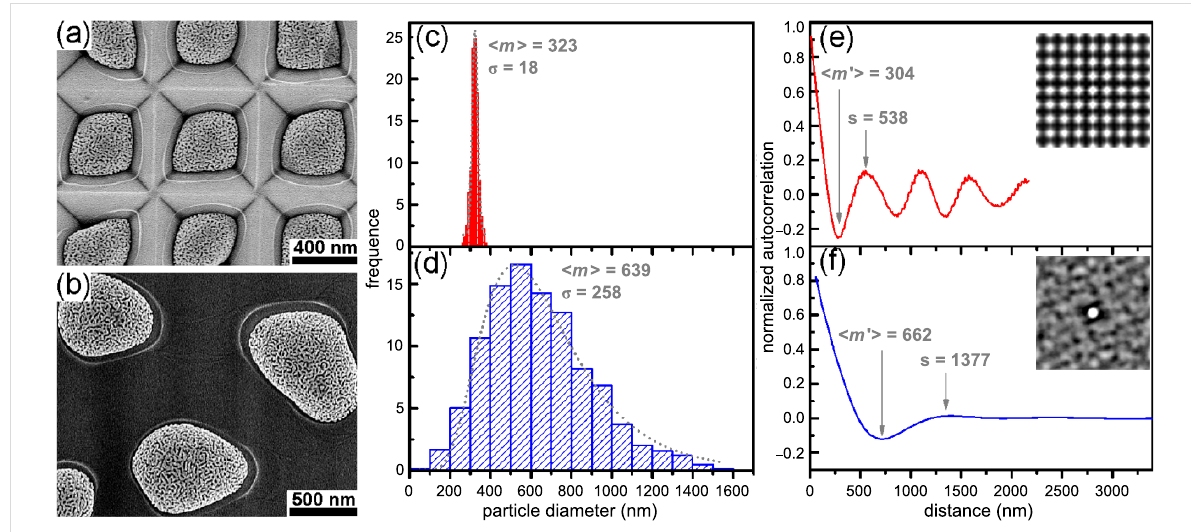
Figure 5: Data for the ordered array of nanoporous gold nanoparticles formed from the 15 nm Au/30 nm Ag multilayers on the prepatterned substrate (a, c, and e) and the irregularly distributed nanoporous gold nanoparticles formed from the 15 nm Au/20 nm Ag bilayers on the flat substrate (b, d, and f). (a, b) SEM images, (c, d) histograms of the particle diameter distributions, and (e, f) plots of radially averaged autocorrelation. Fitting curves (log- normal function) are superimposed on the histograms. The values <m> or <m ′ > and σ indicate the mean particle diameter and its standard deviation, and “s” denotes the characteristic particle spacing (all in nm). Insets in (e) and (f) show the corresponding autocorrelation